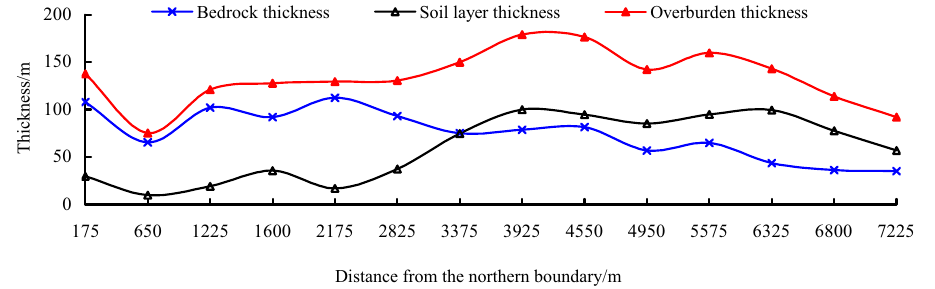
Figure 1. The thickness of bedrock and soil layer in Ningtiaota coal